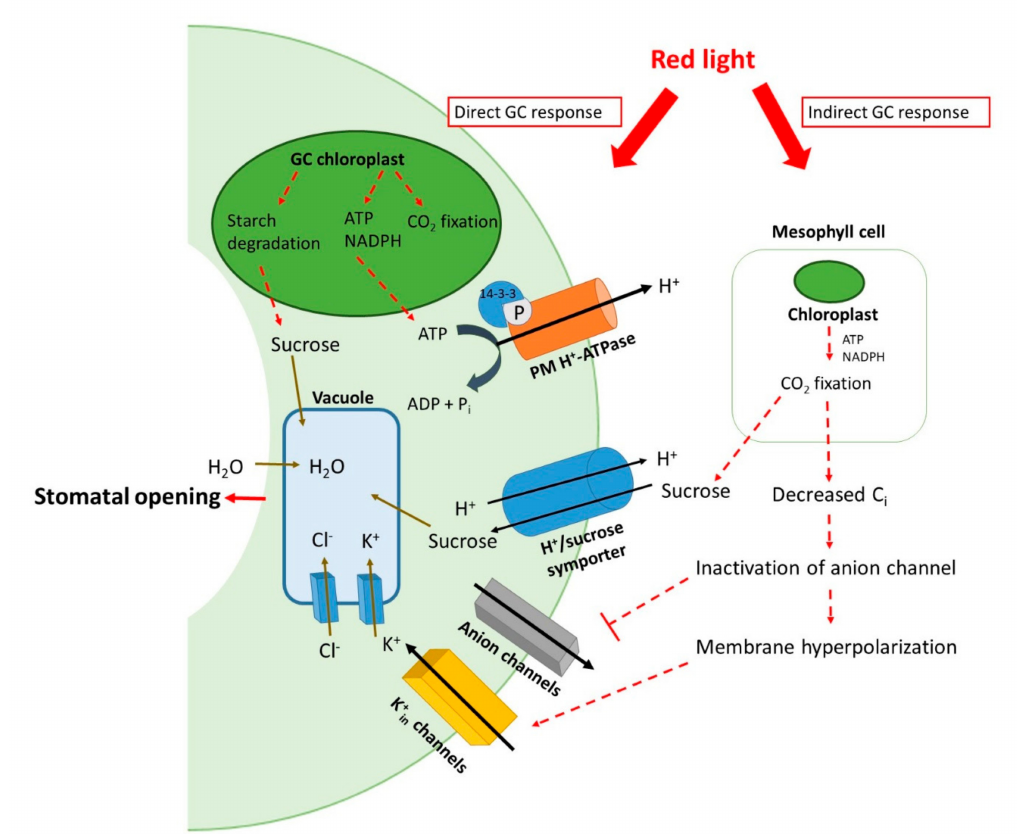
Figure 4. Stomatal opening in guard cells as a result of red light signaling. Red light is absorbed by guard cells (direct GC response) and mesophyll chloroplasts (indirect GC response). ATP and NADPH are provided in the cytosol by guard cell chloroplasts. Starch degradation elevates sucrose levels. Sucrose synthesized in the mesophyll cells is imported via H + / sucrose symporters from the apoplast to the guard cells. CO 2 fixation in mesophyll cells decreases C i concentrations, resulting in membrane hyperpolarization. GC, guard cell; C i , intercellular CO 2